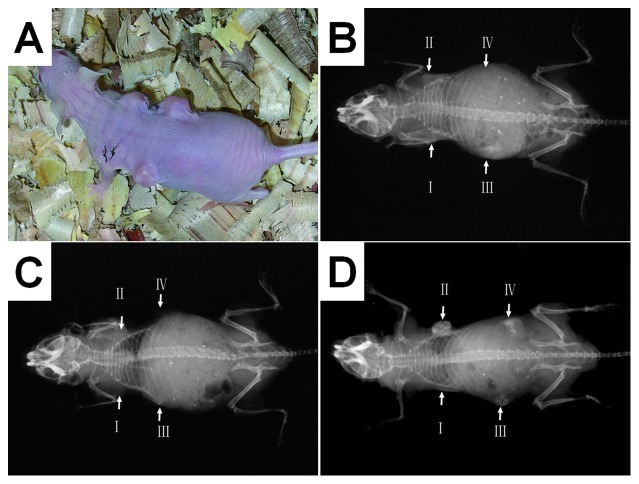
Nude mice subcutaneous implantation model for the evaluation of osteogenic activity; (A) a photograph showing a nude mouse with four implants; (B) a radiograph 4 weeks after implantation; (C) a radiograph 8 weeks after implantation; (D) a radiograph 12 weeks after implantation.The radiographic densities of the implants increased from week 4 to week 12. The osteogenesis of implants was not clear at weeks 4 and 8 postoperative. It was not until 12 weeks postoperative that the imagings of implants in the radiographs were clearly observed. At week 12, implant II clearly showed increased density indicating calcification.